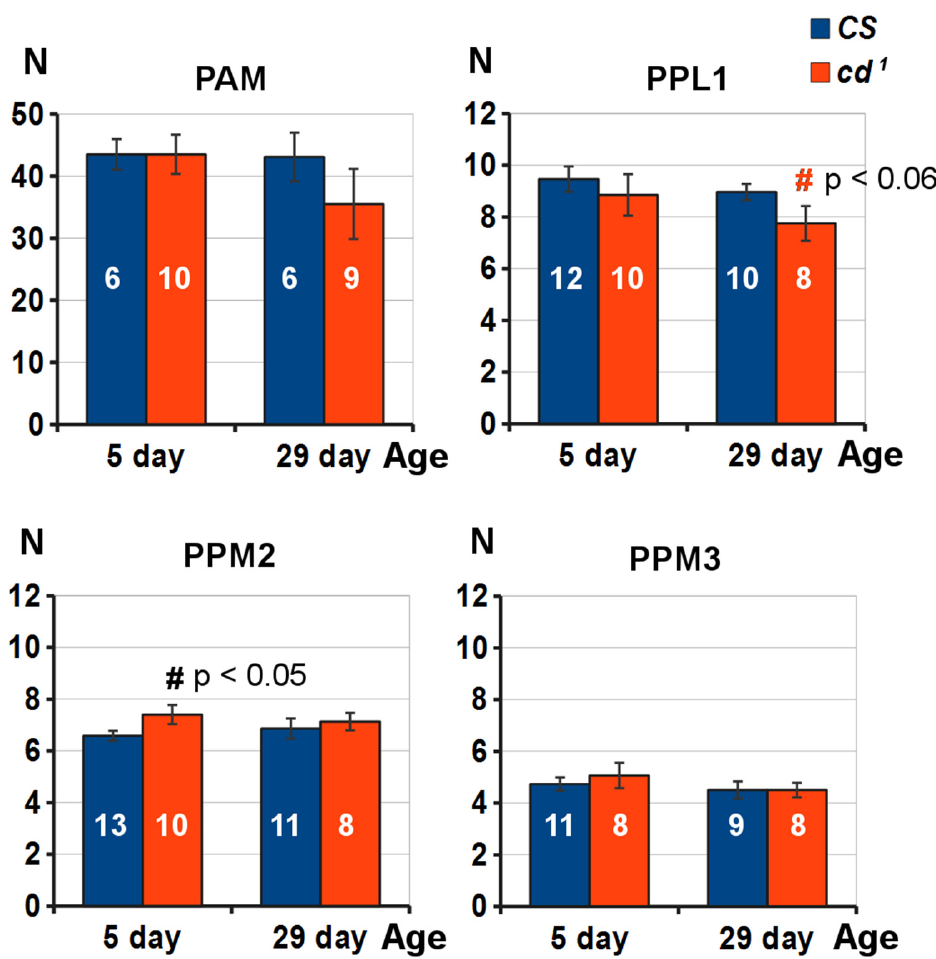
Figure 8. The average number of TH-positive neurons in the Drosophila DAN clusters. X axis: age of the fly (days); Y axis: cell number (N). Statistical difference: # from CS ; two-sided randomization test, p is shown above the chart columns, n is marked with white numbers on the columns.